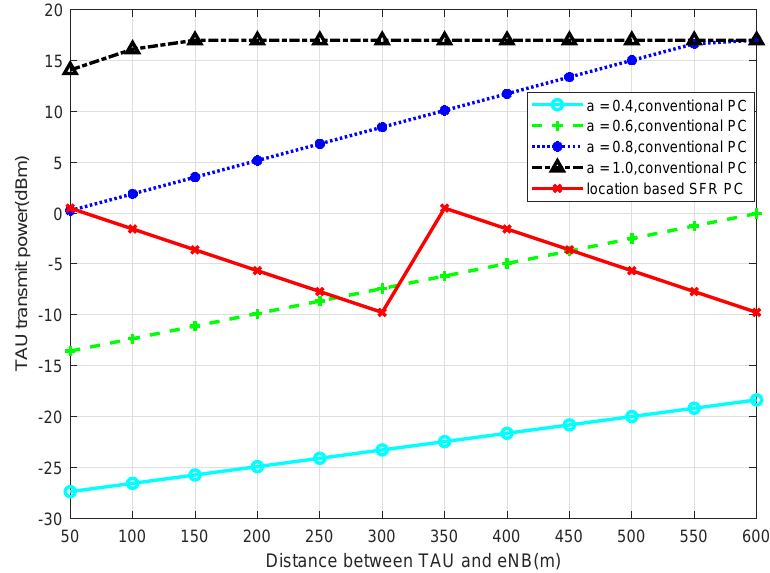
Figure 4. Transmit Power of TAU in 2-SFR.